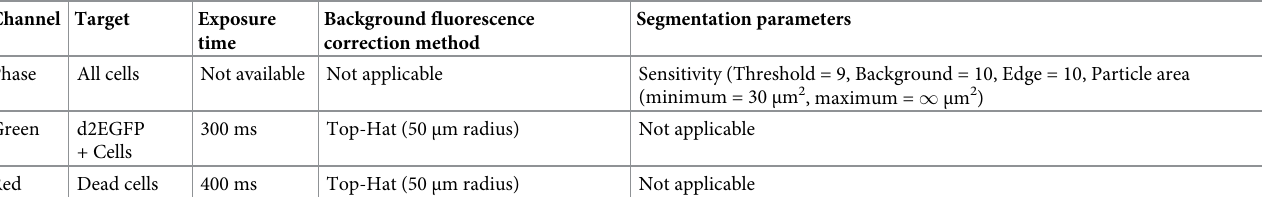
Table 2. Imaging and mask parameters used for image capturing and analysis on Incucyte S3.